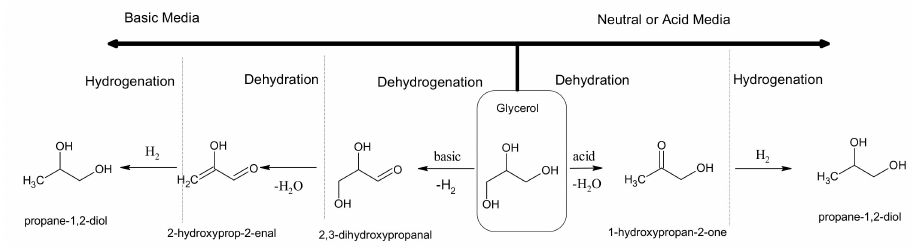
Figure 7. Proposed mechanism for 1,2-Propanediol (1,2-PDO)